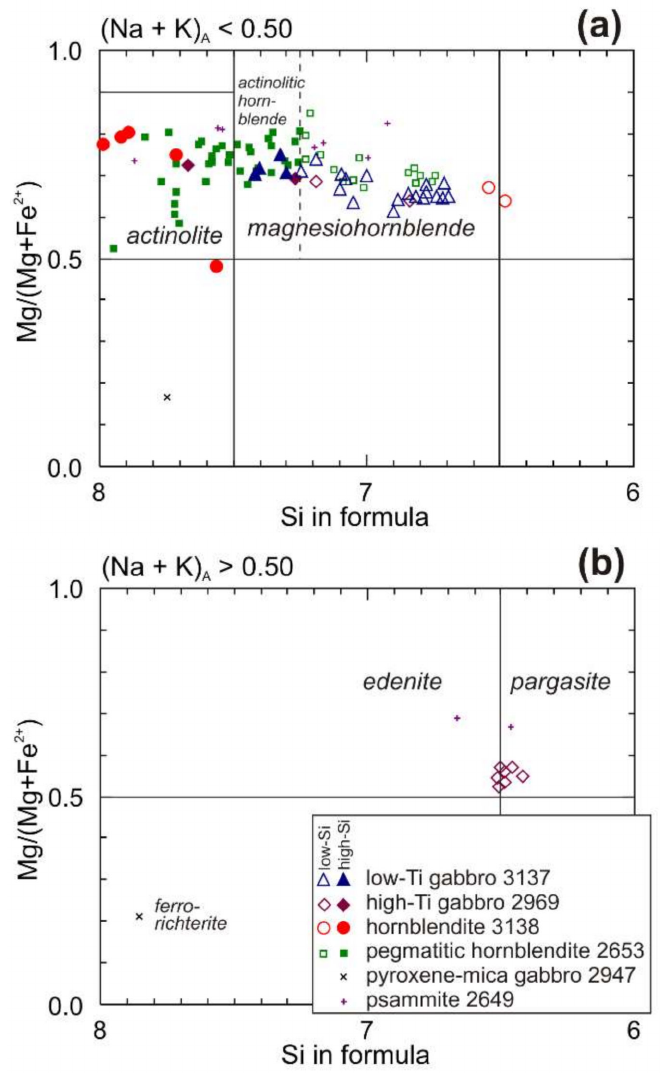
Figure 2. Plots showing the chemical classification (according to [14]) of the amphibole compositions for high-Ti gabbro, low-Ti gabbro, hornblendite, pegmatitic hornblendite and metasomatised psammite. The open symbols correspond to amphiboles with Si < 7.25 (hornblende and pargasite), and the solid symbols correspond to amphiboles with Si > 7.25 (actinolitic hornblende and actinolite). ( a ) shows amphiboles with (Na + K) A < 0.5, ( b ) >